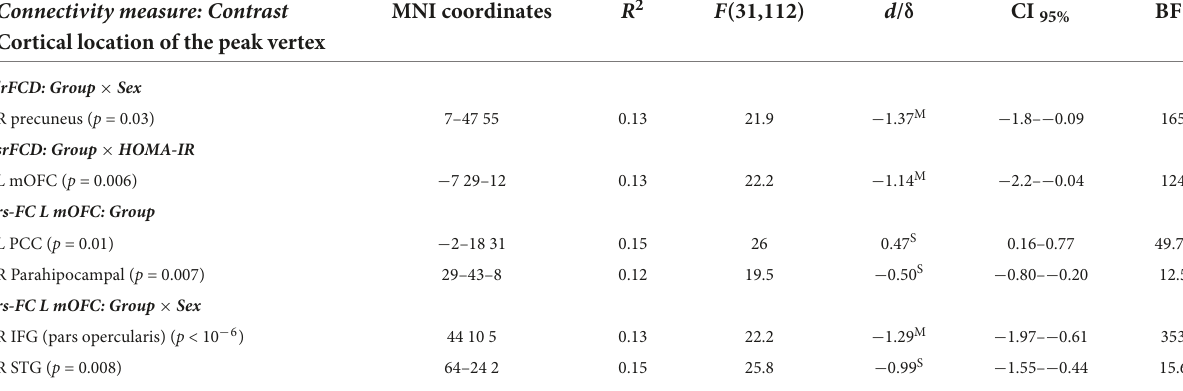
TABLE 2 Significant main effect of group and sex and homeostatic model assessment (HOMA) interaction on functional connectivity density (FCD) and resting-state functional connectivity (rs-FC). Connectivity measure: Contrast MNI